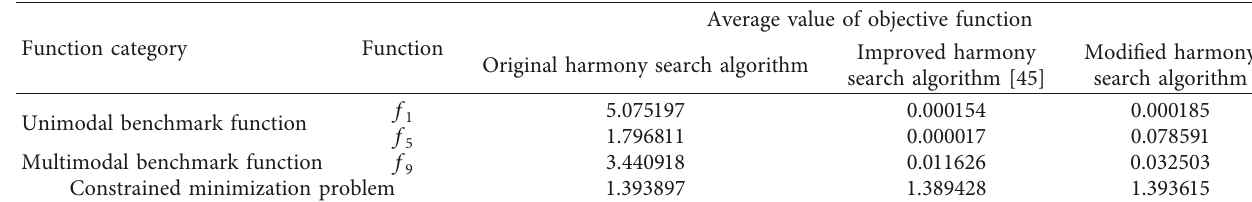
Table 4: The average solution of benchmark functions.